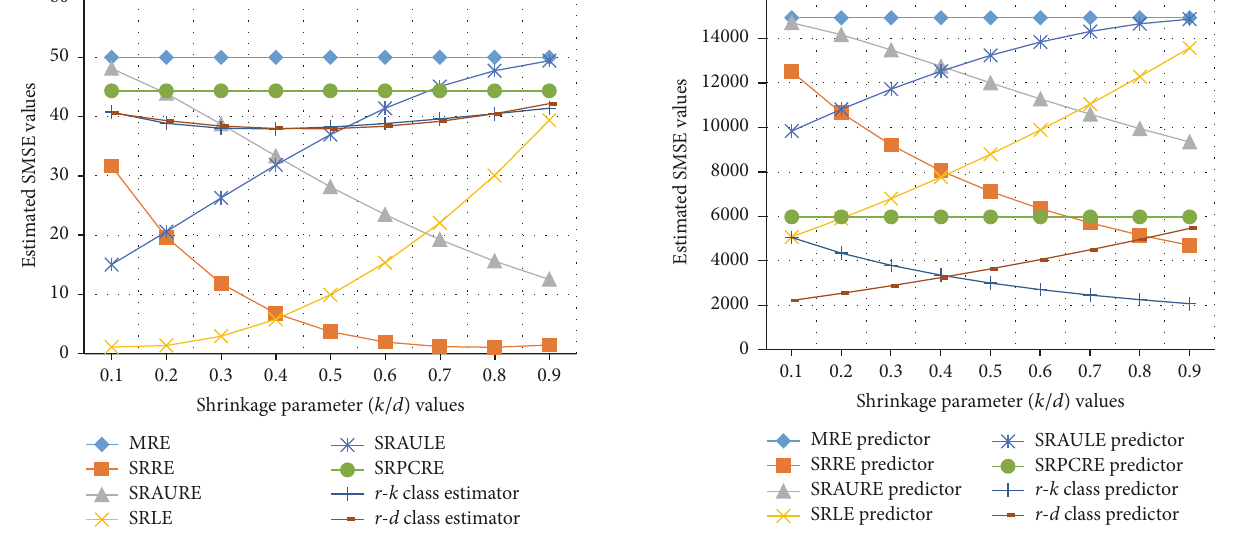
Figure 4: SMSE values of the predictors in the misspecified regression model when 𝑛 = 50 and 𝜌 = 0.9